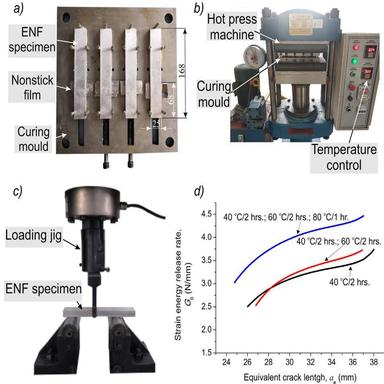
ENF specimen manufacture and testing: a) Specimen moulding, b) Temperature adjustable press machine for mould curing; c) Configuration of ENF test process, d) Different temperatures and durations of typical R-curves.